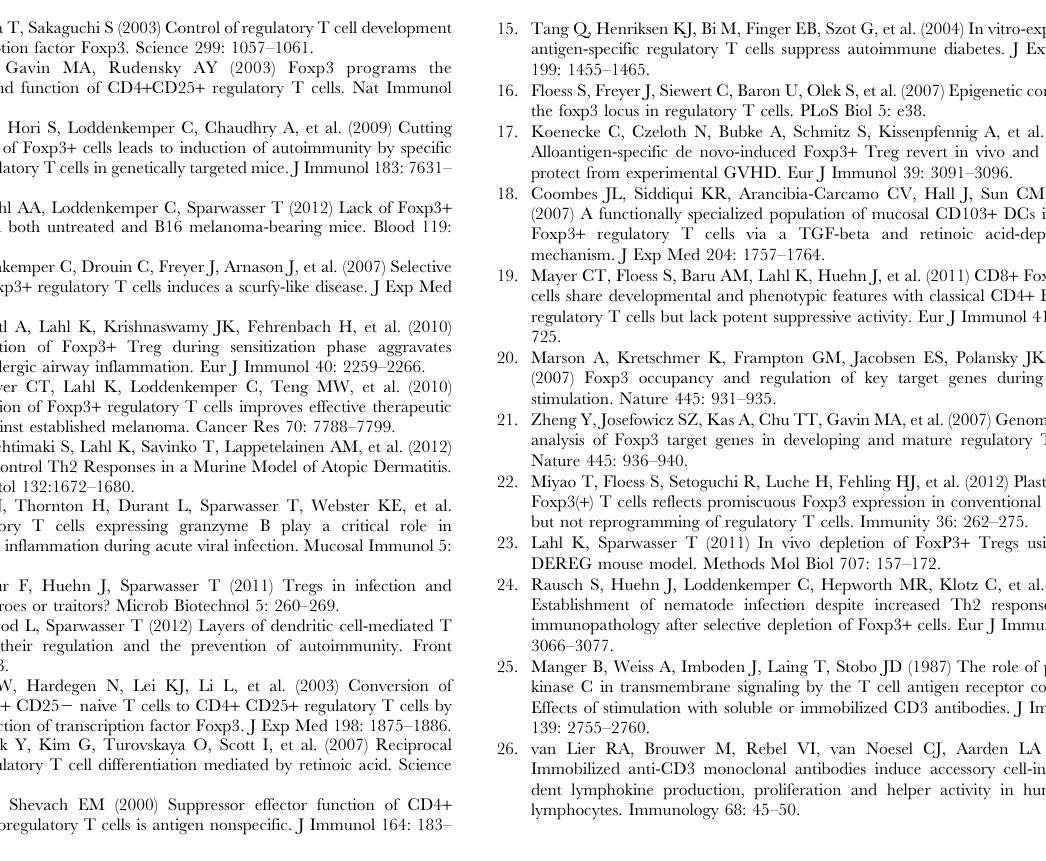
Figure S3 Phenotyping of differentiated CD4 + eGFP + cells from iTreg cultures towards various T helper lineages. iTregs differentiated for 4 days were stimulated with PMA + ionomycin and then stained intra-cellularly for Th1 (IFN- c ), Th2 (IL-13) and Th17 (IL-17A) signature cytokines. FACS plots demonstrate intracellular expression of individual cytokines in live gated CD4 + eGFP + cells. Data shown here is a representative plot of iTregs from one DEREG mouse from two individual iTreg differentiation cultures.